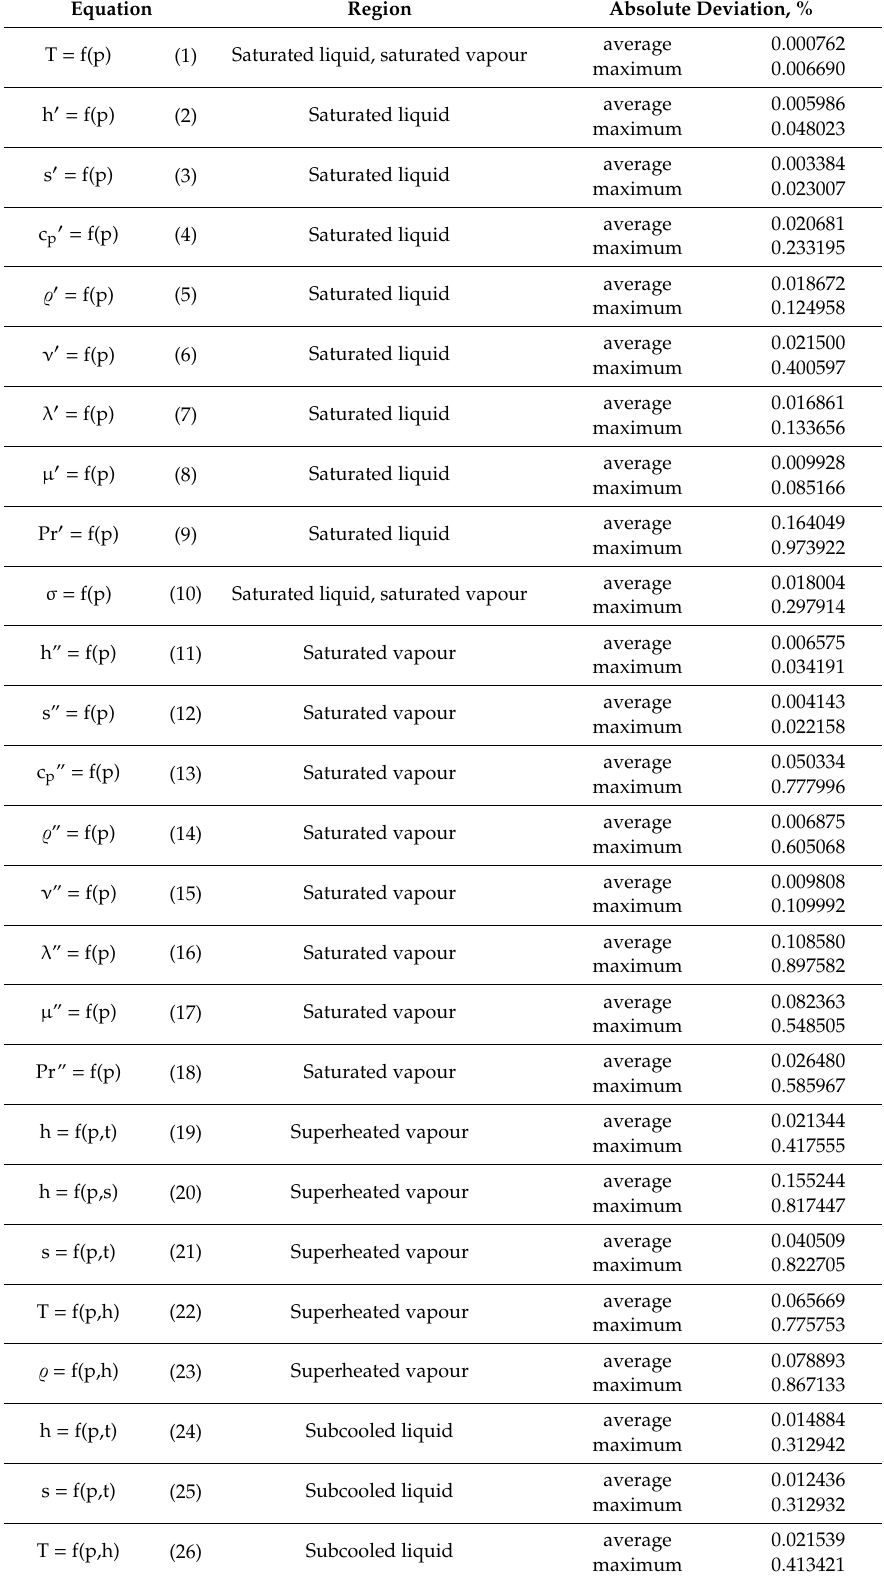
Table 13. Relative deviations between the values obtained from CoolProp 5.1.1 and the calculated values for the R1234ze(E)